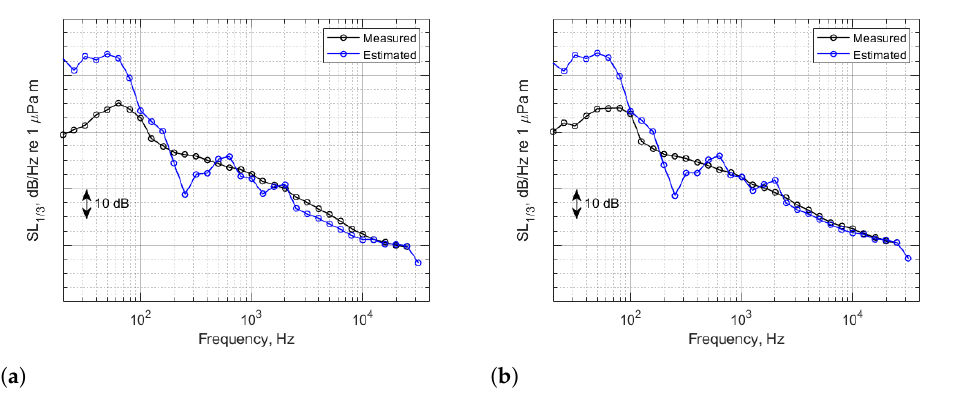
Figure 22. Comparison of measured and estimated source levels for different conditions: ( a ) C 2